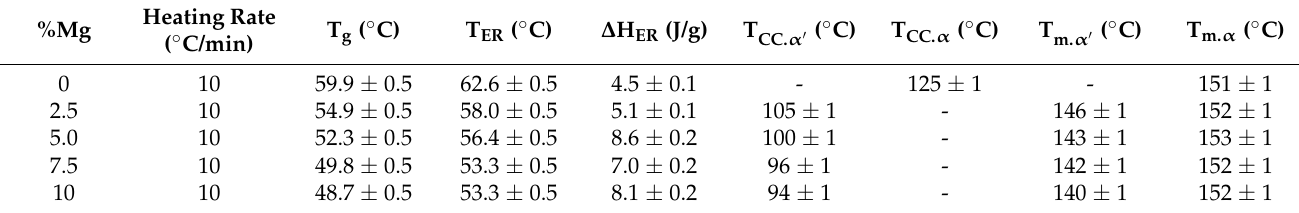
Table 1. Thermal properties of extruded 1D PLA and PLA-Mg filaments at a scanning rate